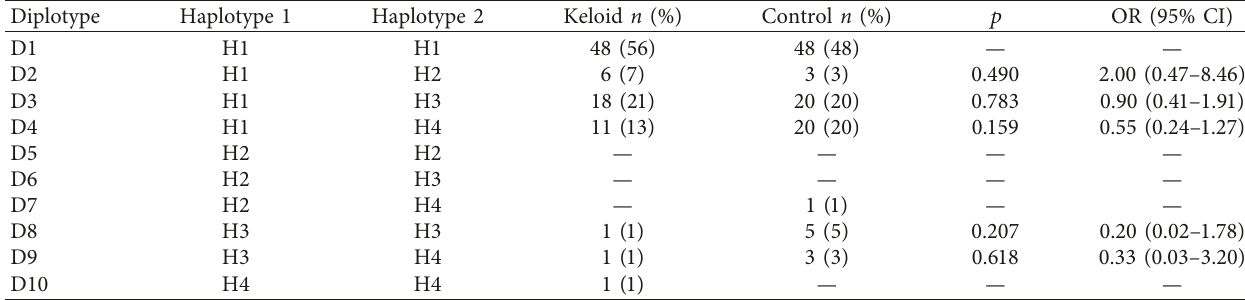
Table 3: Association analysis of TP53 diplotypes with keloid in